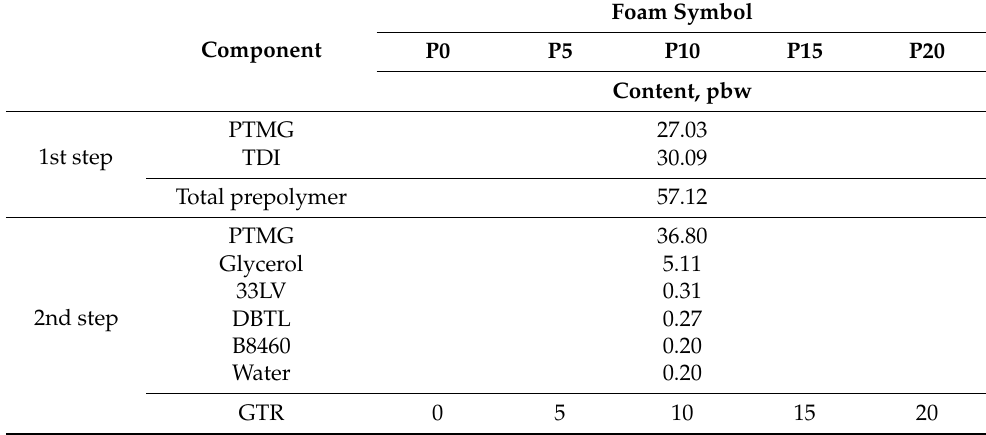
Table 2. Formulations of PU foams analyzed in the presented study. Foam Symbol Component P0 P5